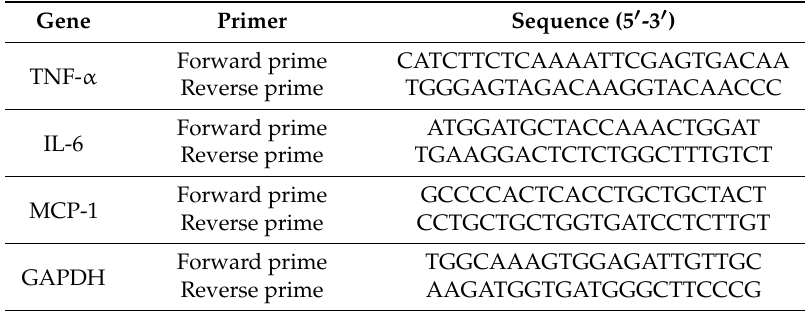
Table 1. Primers used for